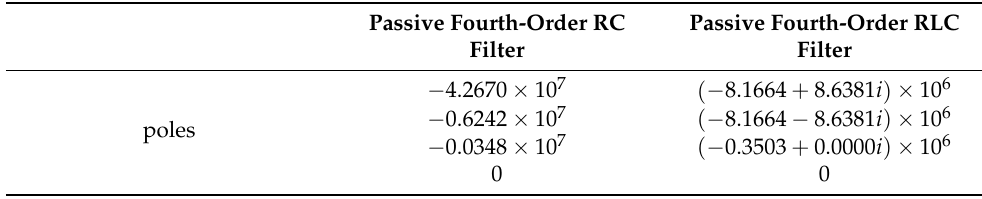
Figure 3. Loop structure: ( a ) passive fourth-order RC filter and ( b ) passive fourth-order RLC filter. The closed-loop stability can be realized if, and only if, all roots of the characteristic equation of the closed-loop system have negative real parts [18]. It should be noted that stability is independent of the zero location. Table 2 shows the closed-loop system poles obtained by combining Equations (4), (7), and (8). As shown in Table 2, and since all poles of the closed-loop system are located in the left half plane, the circuit is stable. Table 2. The closed-loop system poles. Table 2. The closed-loop system poles.